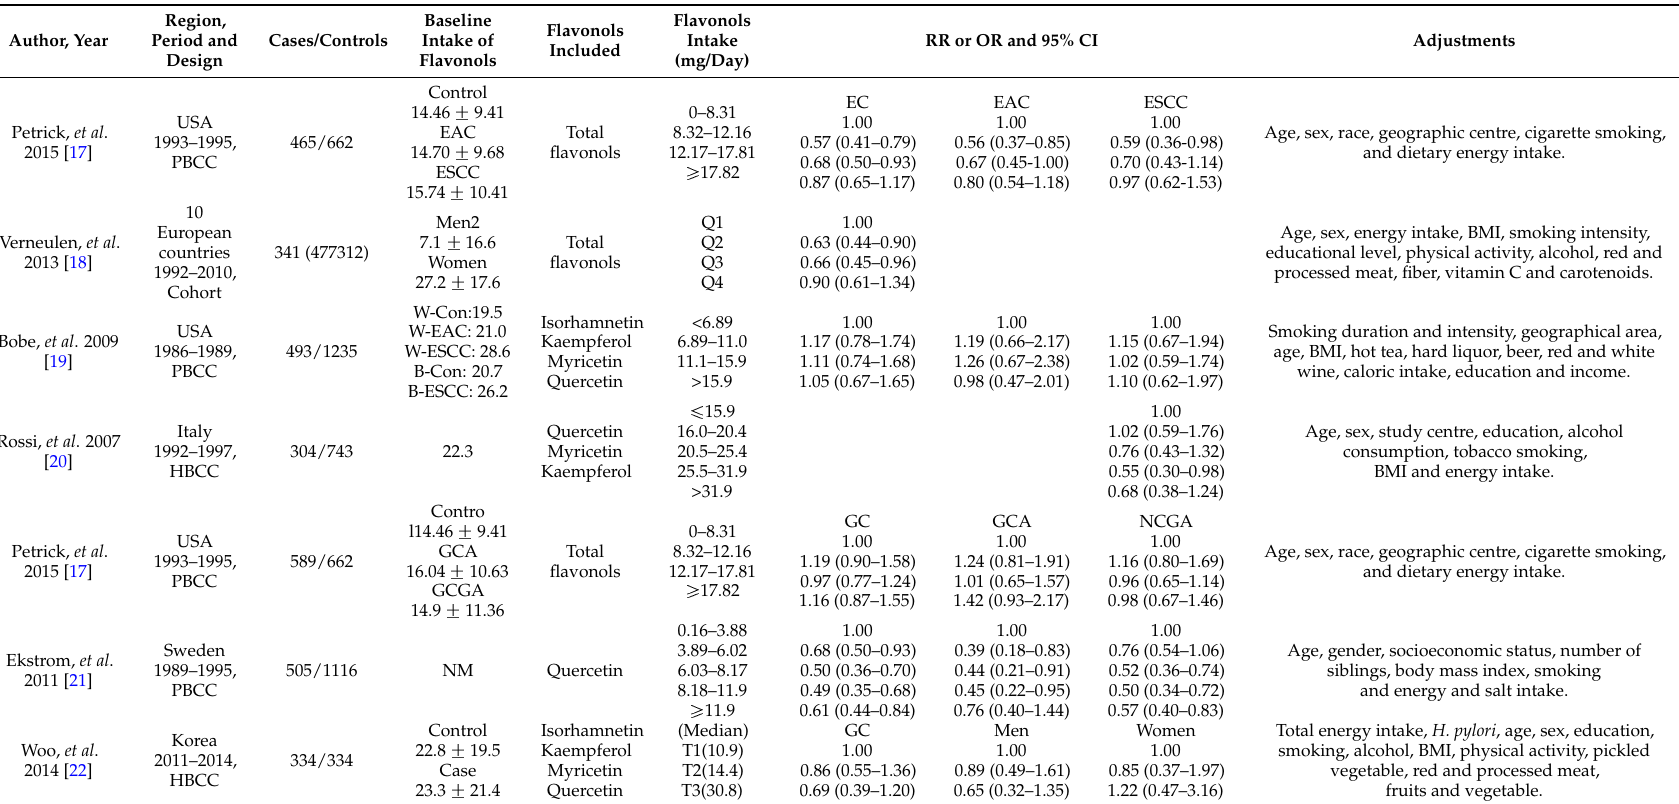
Table 1. Characteristics of the included